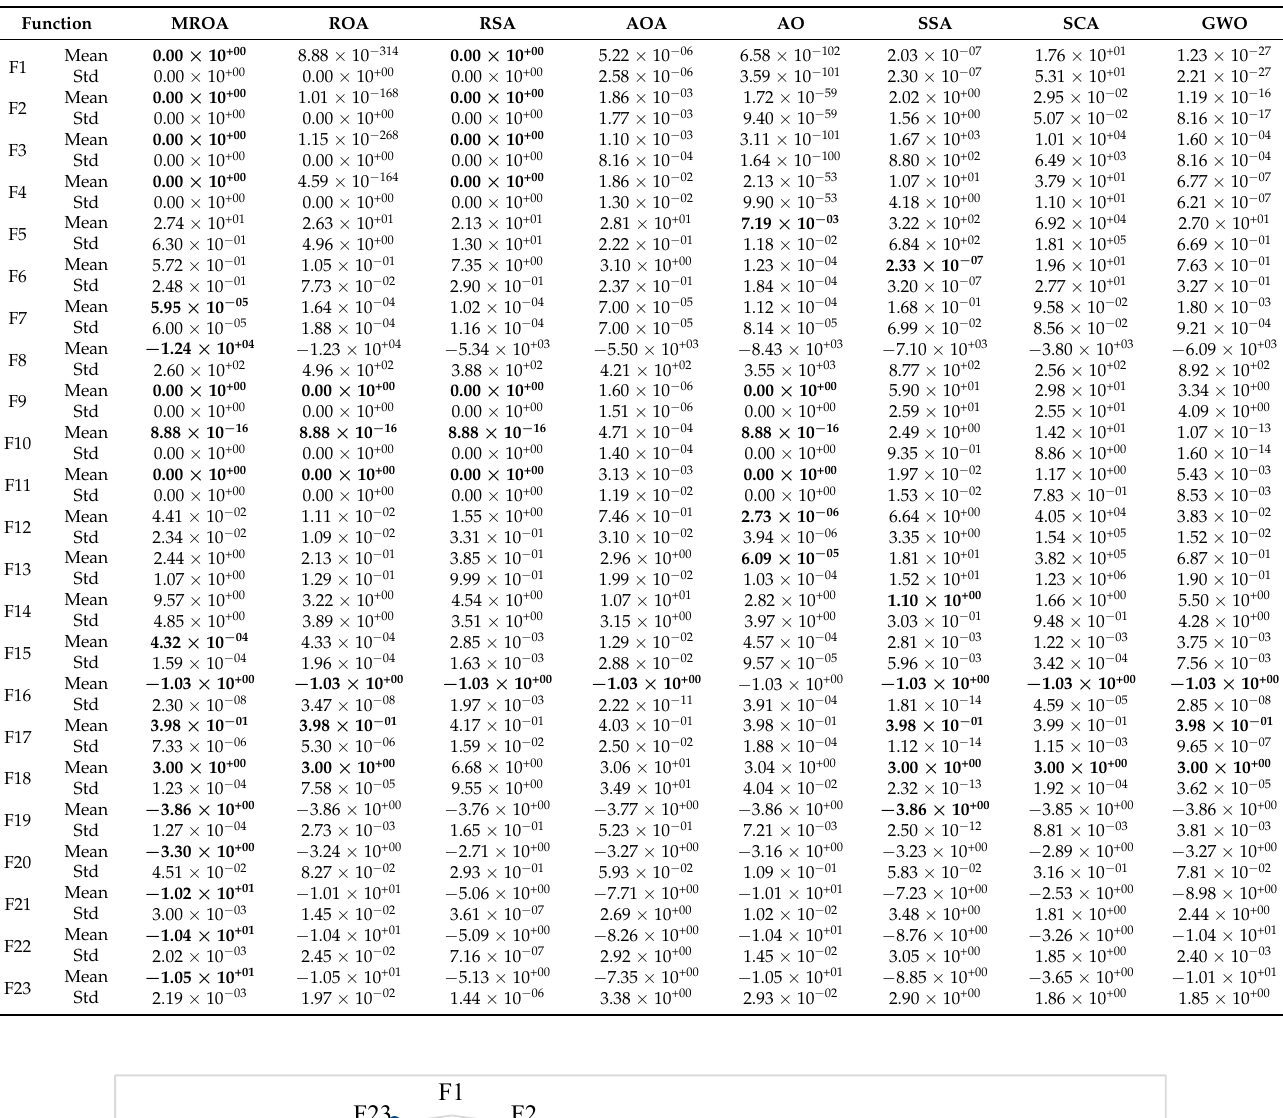
Table 3. Statistical results of algorithms on 23 benchmark functions.